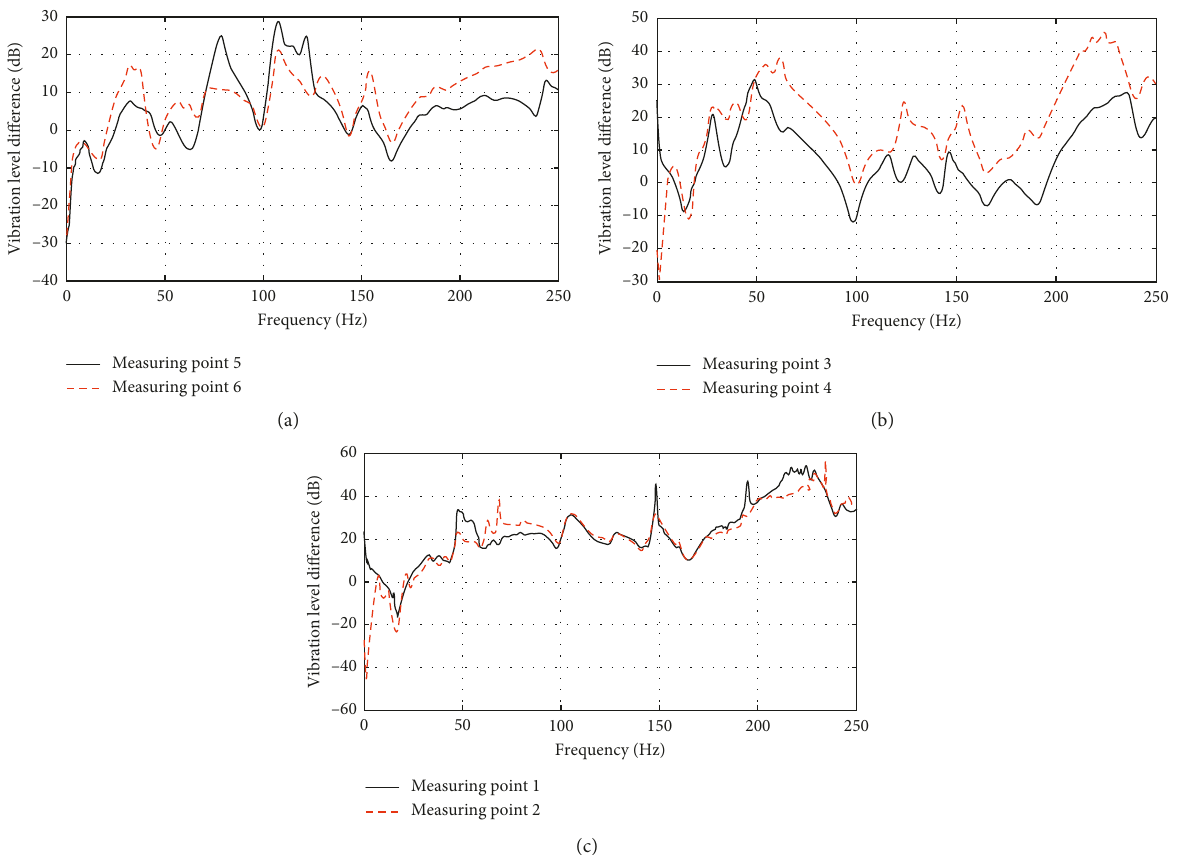
Figure 9: Acceleration-vibration level differences. Measuring points: (a) 5 and 6, (b) 3 and 4, and (c) 1 and